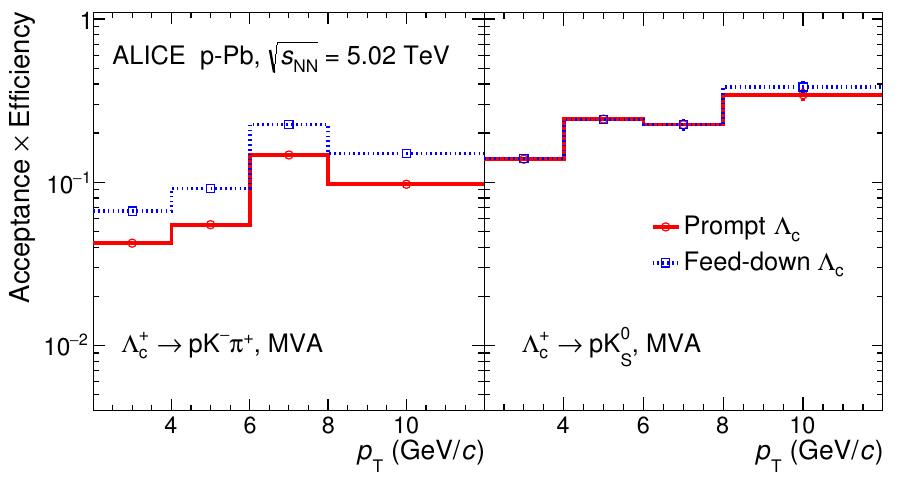
Figure 7 . Product of acceptance and e(cid:14)ciency for the two (cid:3) c hadronic decay channels in p-Pb p collisions at s NN = 5.02 TeV, as a function of p T with the MVA technique. From left to right: ! pK 0 (cid:3) + ! pK (cid:0) (cid:25) + and (cid:3) + . The solid lines correspond to the prompt (cid:3) c , while the dotted lines c c S represent ( A (cid:2) (cid:15) ) for the (cid:3) c from beauty-hadron decays. The statistical uncertainties are smaller than the marker